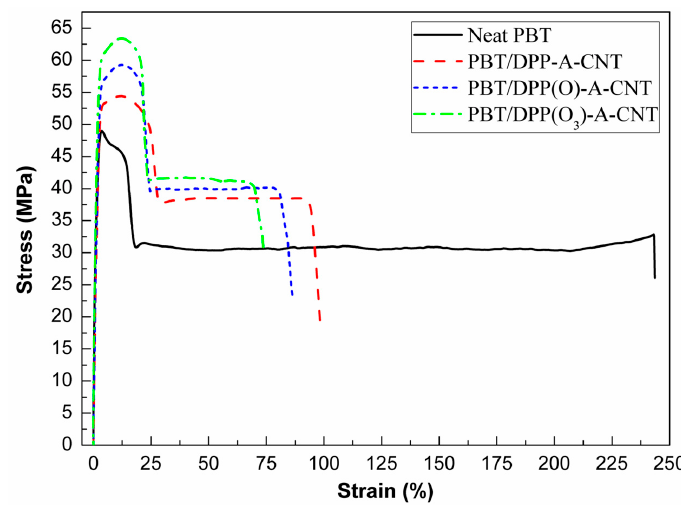
Figure 7. Tensile stress-strain curves of neat PBT, PBT/DPP-A-CNT, PBT/DPP(O)-A-CNT and PBT/DPP(O 3 )-A-CNT. Table 3. Tensile properties for each sample.